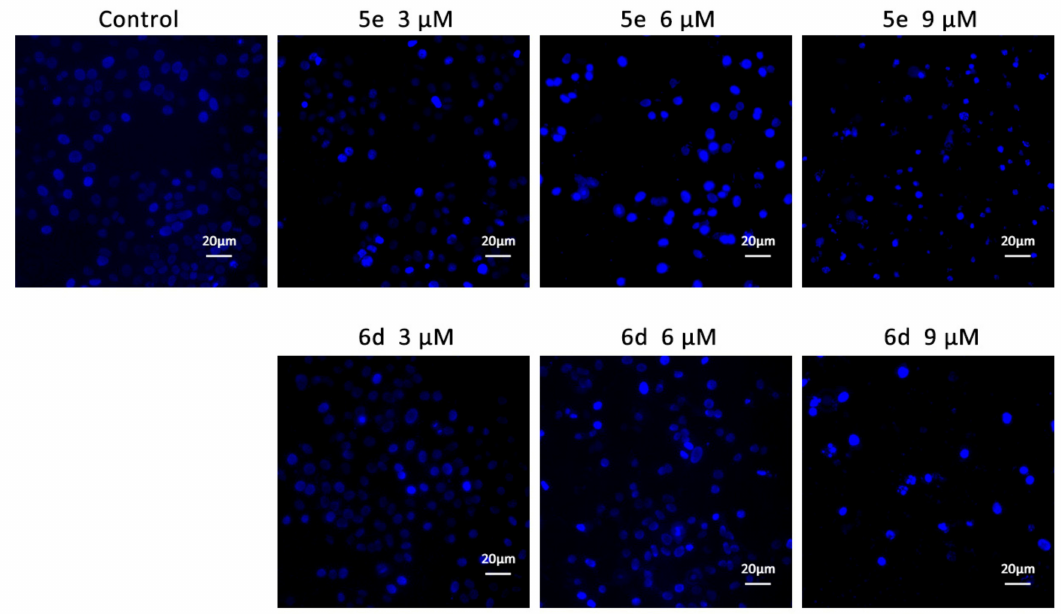
Figure 3. Hoechst staining for apoptosis. HepG2 Cells were treated with the indicated concentrations of 5e and 6d for 24 h, stained with Hoechst 33258 and examined with a fluorescent